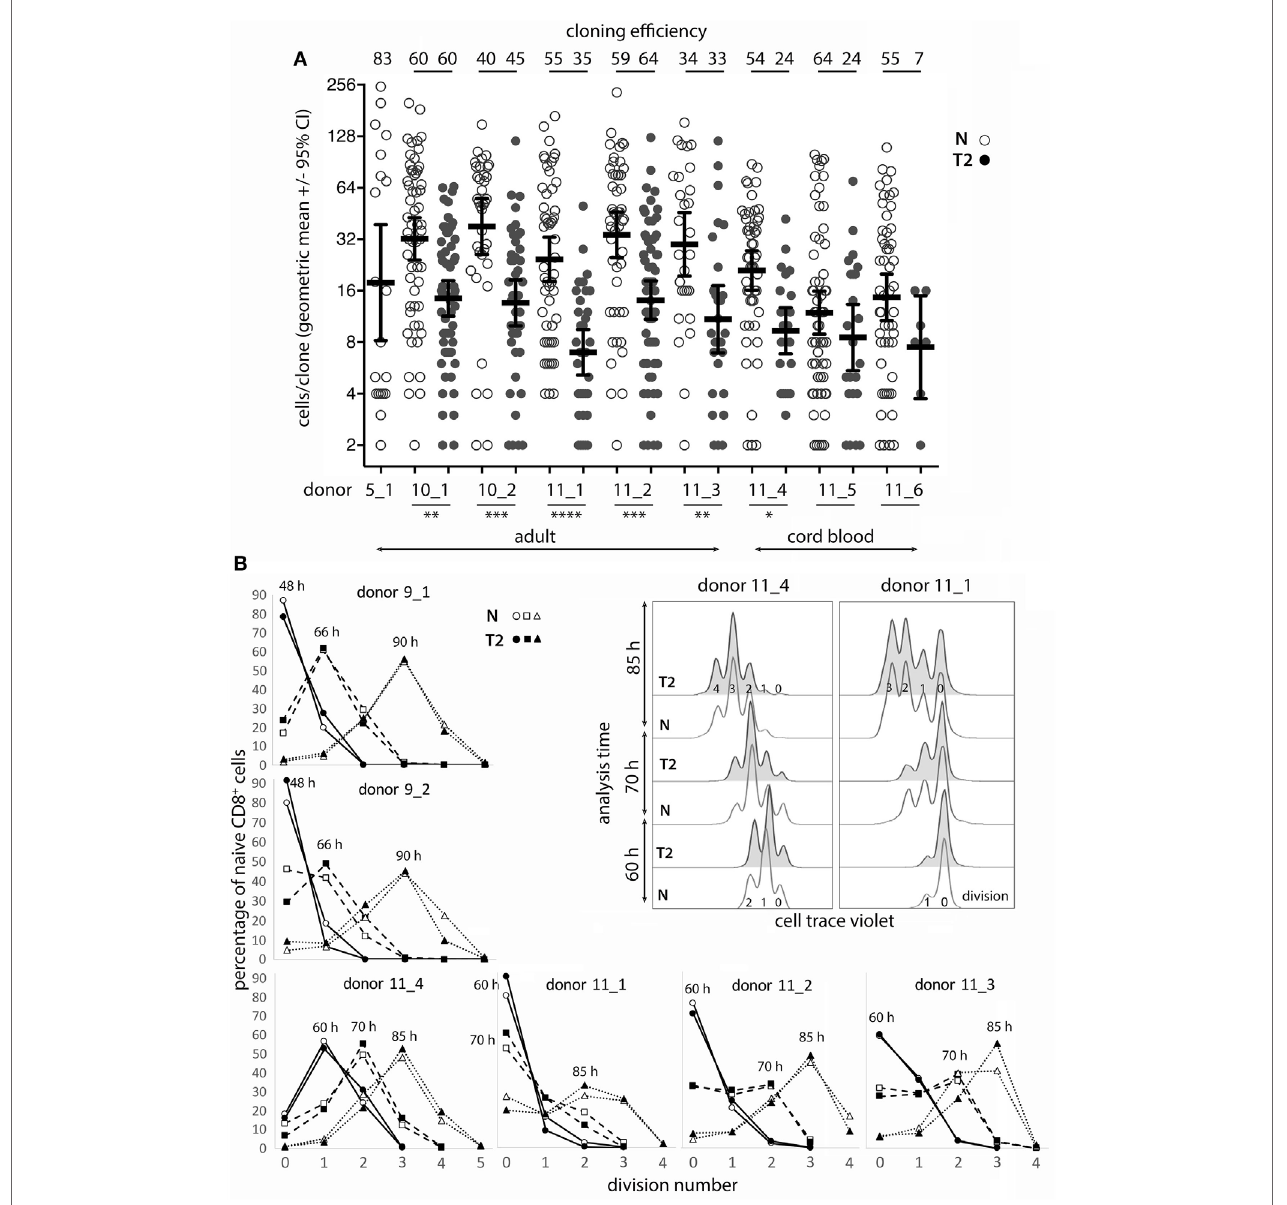
FigUre 1 | Naïve CD8 + T-cell cloning and division in neutral or type-2 (T2) conditions. (a) Single naïve CD8 + T cells were sorted into mAb-coated 96-well plates and cultured for 6 days in neutral (N) or T2 conditions. Each dot represents a clone and the percentage of single cells that formed a clone (cloning efficiency) is shown above each donor/condition. p -Values for within-donor comparisons of clone size in N versus T2 conditions are indicated (**** p < 0.0001, *** p < 0.001, ** p < 0.01, and * p < 0.05). (b) Cells from six donors were cell trace violet (CTV) labeled and cell division was assessed at various times between 48 and 90 h after activation in N and T2 conditions. Overlay histograms show CTV staining (2 of 6 donors shown), and line graphs show percentages of CD8 + T cells in each division. Analysis times are indicated above the peak for each